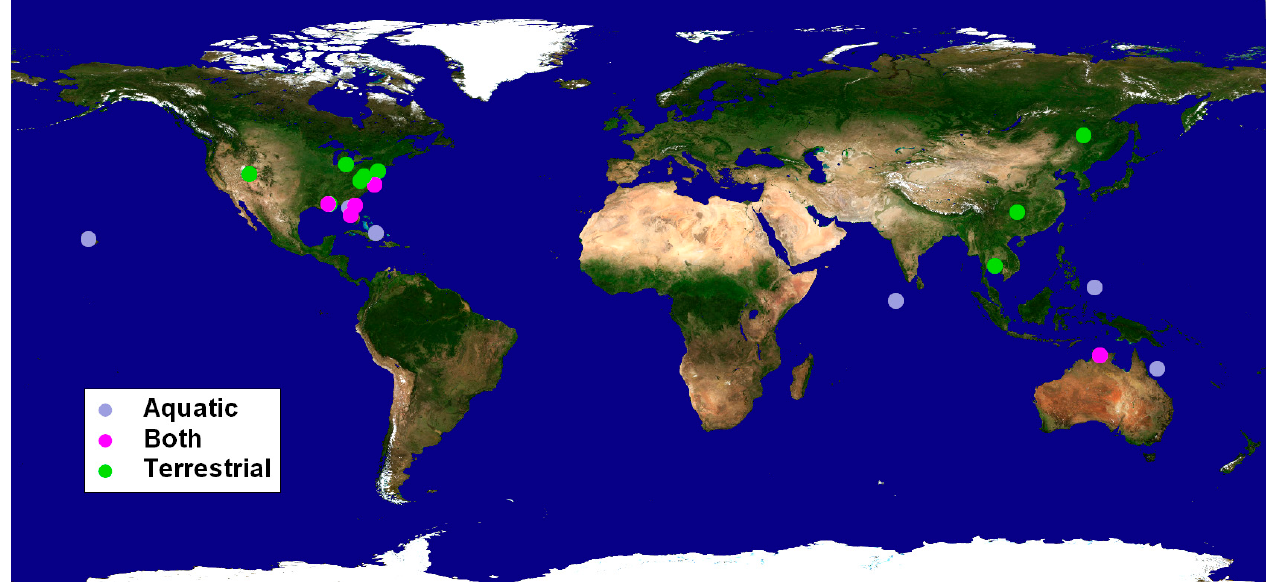
Figure 1. Map highlighting the geographic distribution of the study areas of the articles comprising the Special Issue, and the type of ecosystems (i.e., aquatic, terrestrial or both) involved.